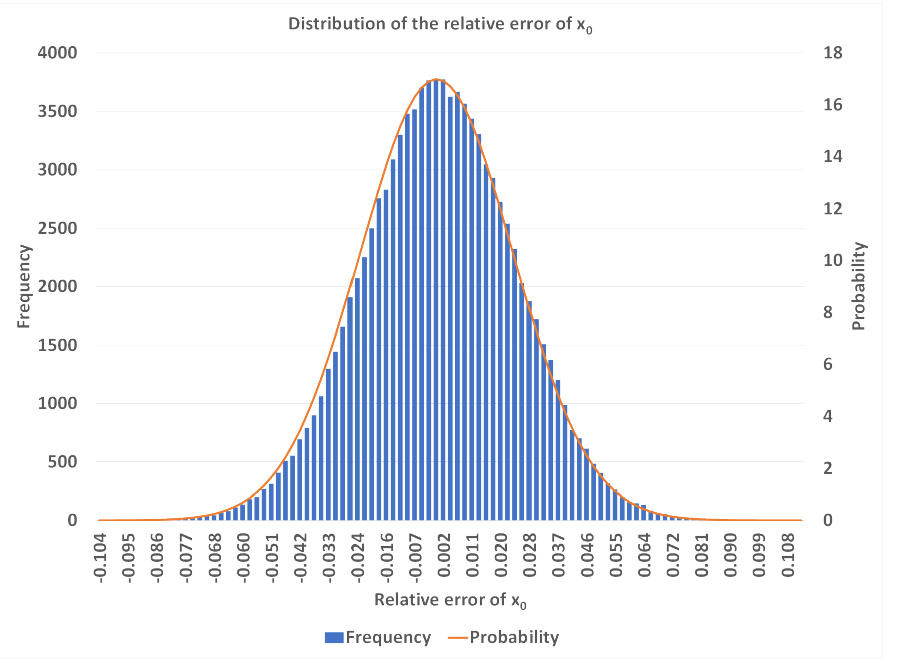
Figure 5. Normal distribution of the relative error of x 0 , with α = 9.0 ◦ , β = 1.0 ◦ , δ = 0.05%, and K =